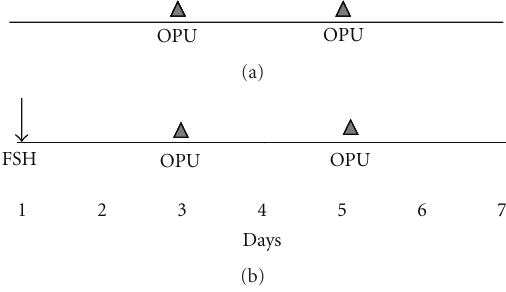
Figure 1: Weekly scheme and hormone treatment for Ovum pick- up (OPU). (a) The animals were not treated with hormone FSH. Transvaginal OPUs (triangle) were performed on Monday and Thursday of each week for consecutive two weeks, resulting in a total of four sessions. (b) FSH treatment: FSH (arrow) at dosage of 80mg IM and 120 SC was simultaneously administered on Day 1 (Saturday). Ovum pick-ups were performed 48 and 96 hours post FSH injection, meaning on Day 3 and Day 5 of each week for consecutive two weeks, resulting in a total of four